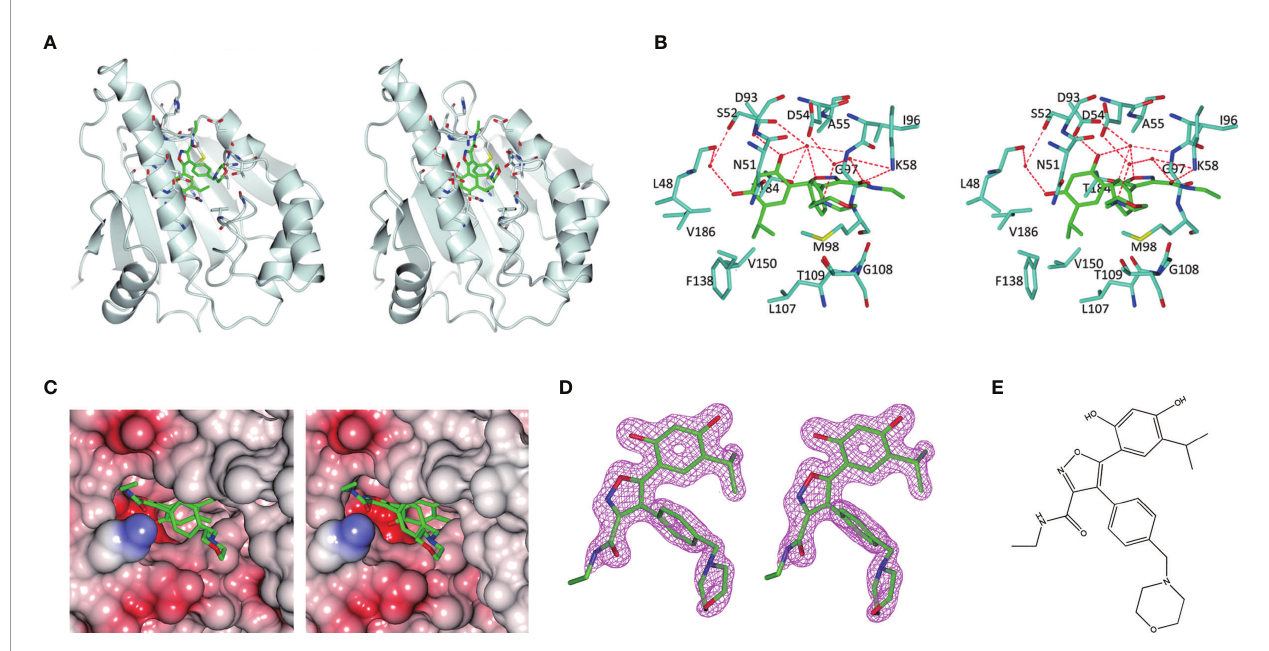
FIGURE 3 | Molecular interaction analysis for NVP-AUY922 and Hsp90 N by thermal shift assay (TSA) and isothermal titration calorimetry (ITC). (A) Melting curve of protein Hsp90 N . (B) Melting curve of Hsp90 N binding with NVP-AUY922. (C) D Tm. (°C) The melting temperature differences of Hsp90 N binding with or without NVP- AUY922 ( − 15.56 ± 1.78°C). Values were presented as Mean ± SD, *** P < 0.001, n = 8. (D) ITC plots for Hsp90 N binding with its ligand NVP-AUY922. Upper panel: the raw titration data. A constant temperature against time was maintained, interaction heat for injection was given by the area of each peak. Lower panel: the bimolecular data fi tting of normalized heats against the molar concentration during Hsp90 N -NVP-AUY922 binding process. Titrations were performed in PBS (pH 7.5) at